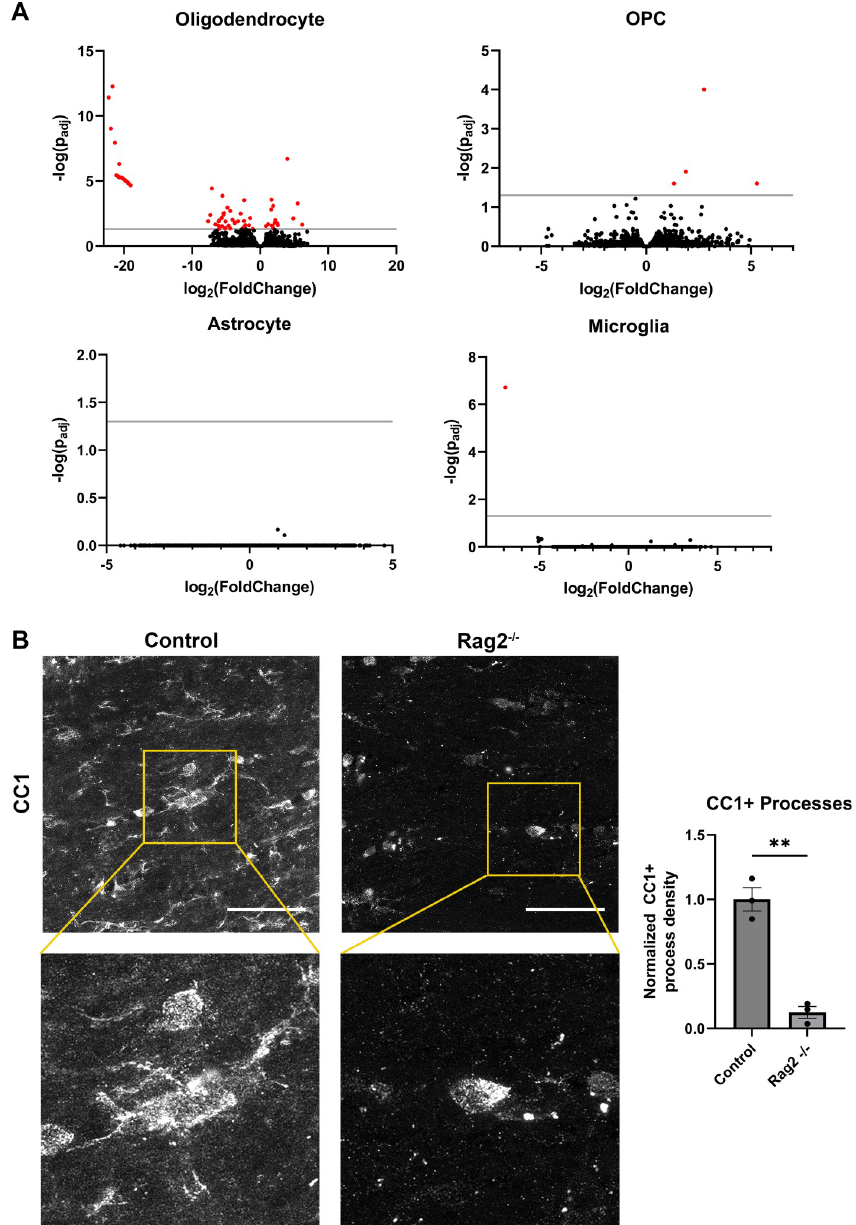
Fig 2. Differential gene expression of glial cells in Rag2 -/- mice. A) Volcano plots displaying differential gene expression analysis of oligodendrocytes (top-left), OPCs (top-right), astrocytes (bottom-left), and microglia (bottom- right). Differential gene expression was analyzed using DESeq2, and the resulting fold change and statistical significance are plotted on the x and y axes respectively. Red: p < 0.05; gray line: p = .05. B) Loss of CC1 expression in cellular processes. Top: Representative images of CC1 in the corpus callosum of control (left) and Rag2 -/- (right) mice; Bottom: Insets of control showing CC1+ processes extending from a CC1+ cell bodies and KO showing only CC1 + soma. Right: Quantification of CC1+ process density, normalized to average control levels (right, p = 0.0034; mean [control, KO] = 1.0, 0.1246; SD[control, KO] = 0.157, 0.081; error bars = SEM). Scale bar = 50 μ m. that Kdm6a expression was significantly higher in female astrocytes compared to males, which agrees with our previous findings from RNAseq of human astrocytes [77].